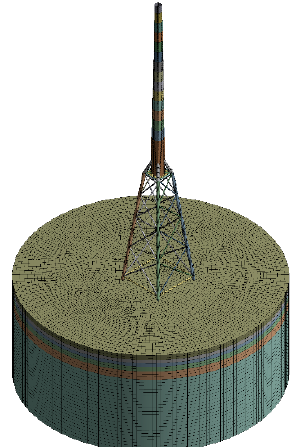
Figure 3. Mesh convergence test.